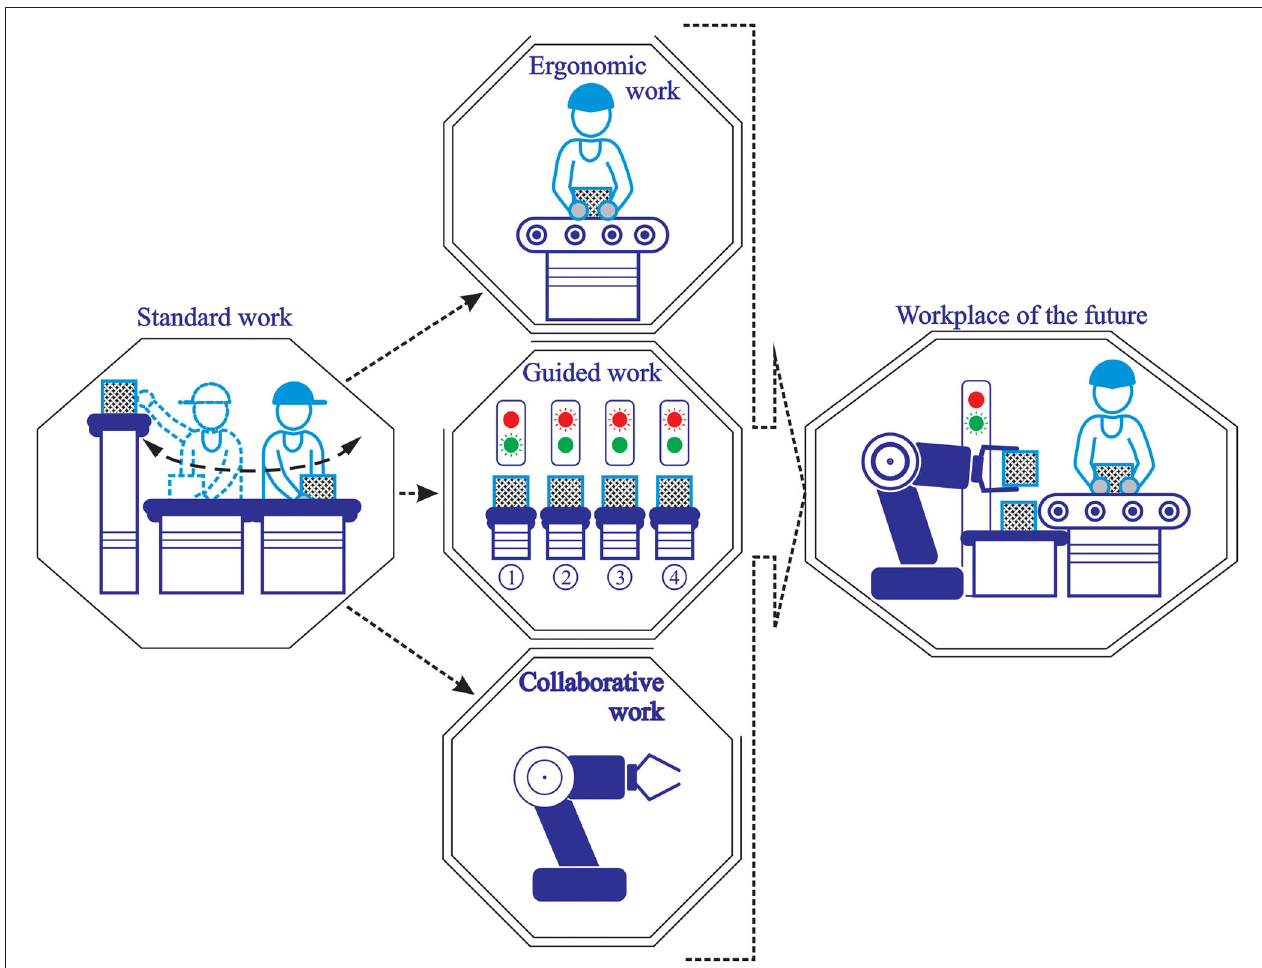
FIGURE 4 | The research